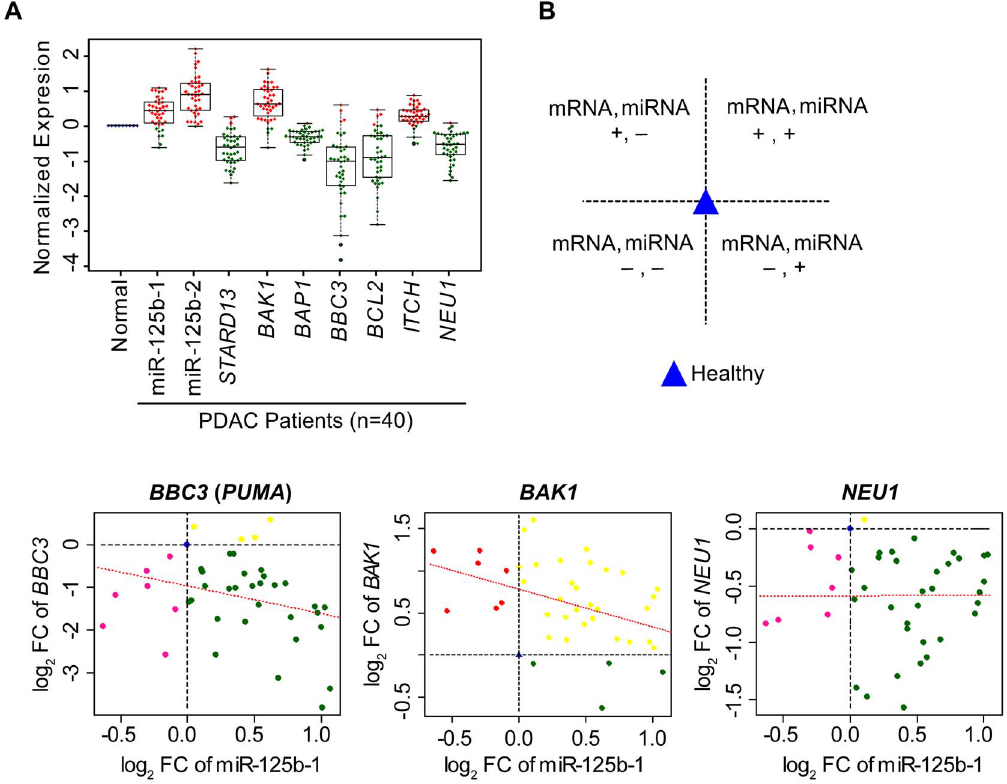
Figure 5. Gene targets of miR-125b. TCGA data analyses were performed with the clinical pancreatic tumor specimens (n=40) for miRNA expression with the corresponding target mRNAs. A. Target mRNA expression profile analyses for miR-125b. Determined the expression of known miR-125b targets ( BBC3 (PUMA), BCL2 , STARD13 , BAK1 , BAP1 , ITCH and NEU1 ). B. A direct co-relation of the target mRNA and miR-125b expression level were measured in the same tumor from pancreatic adenocarcinoma [PDAC] patient’s sample. First panel explains the different quadrants which includes up-regulation ( + Ve sign) or down regulation ( - Ve sign) of mRNA and miRNA expression levels. Other panels are representing expression level of different mRNA ( BBC3, Neu1 and BAK1 ) compared with the expression of miR-125b in the same tumor.